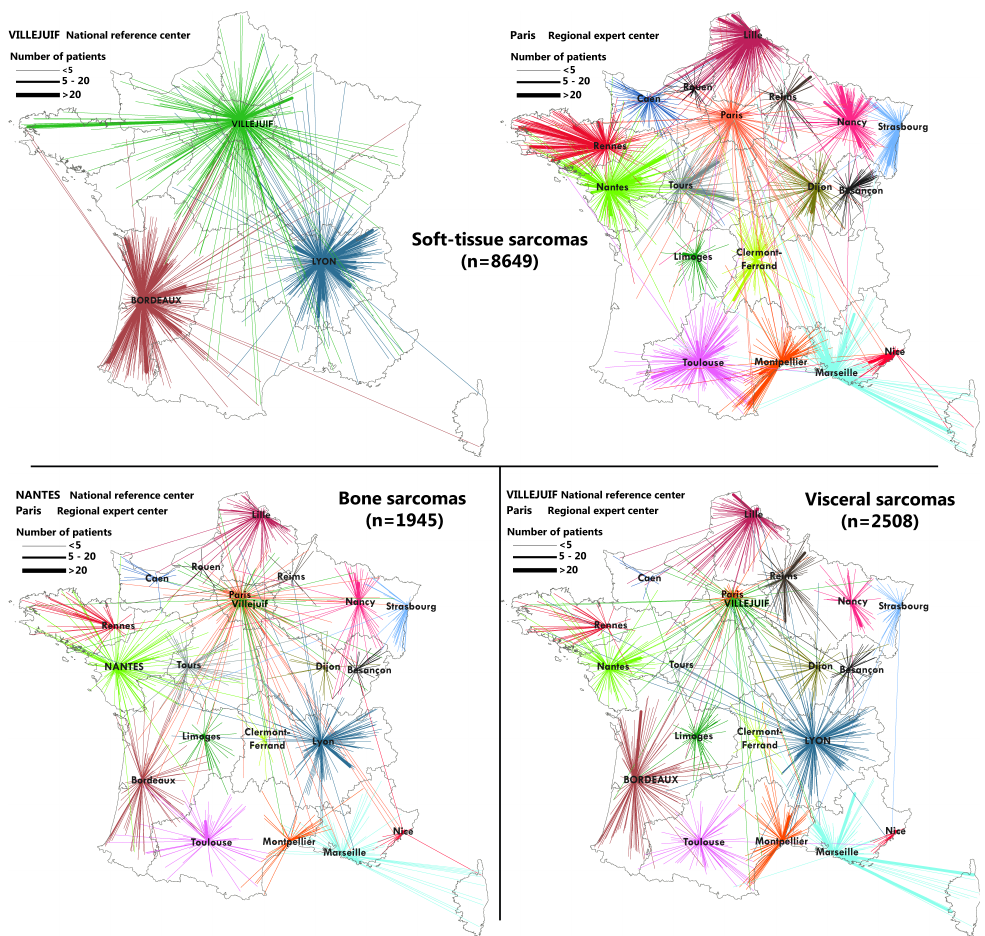
Figure 2 Figure 2. Sarcoma patients’ dwelling place in mainland France (diagnosed between 2011 and 2014) and place of their expert MTB